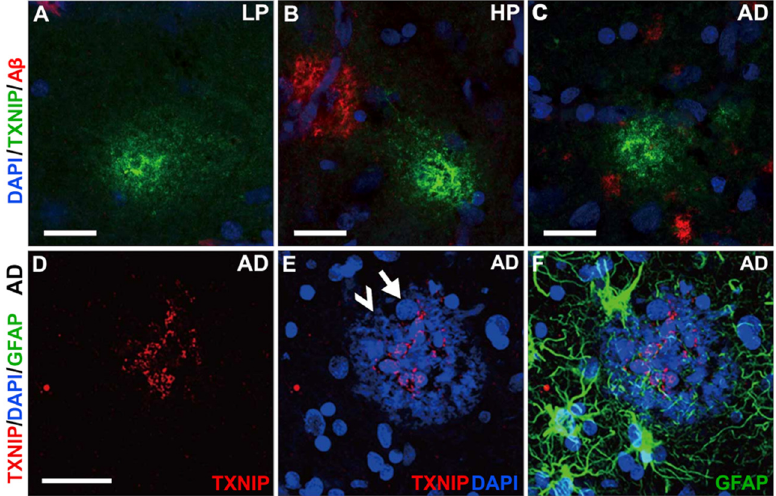
Figure 9. TXNIP immunoreactive plaque structures. ( A – C ). TXNIP immunoreactive plaque-like structures (green) present in LP ( A ), HP ( B ), and AD cases ( C ) do not colocalize with A β (red). Bars represent 20 μ m. ( D – F ). Some mature plaques have TXNIP immunoreactivity (red) ( D ). Plaque revealed by accumulations of DAPI staining of nuclei (white arrow) but also amyloid-like material (white arrowhead) structures ( E ). Plaque-associated GFAP-positive astrocytes (green) accumu- lated around plaque-like structures and did not show TXNIP immunoreactivity ( F ). Bars represent 30 μ m.